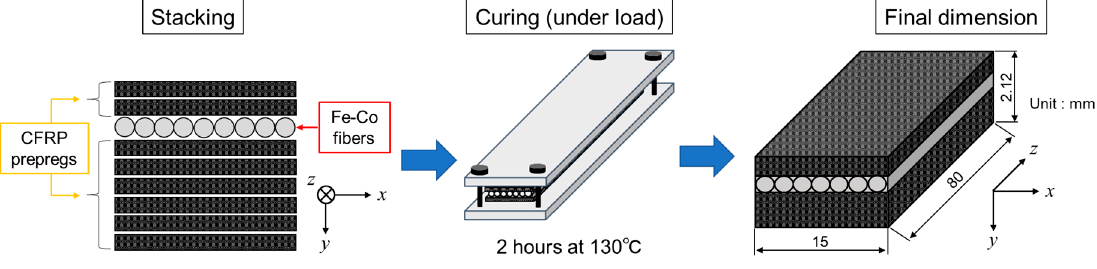
Figure 1. Schematic for specimen preparation.